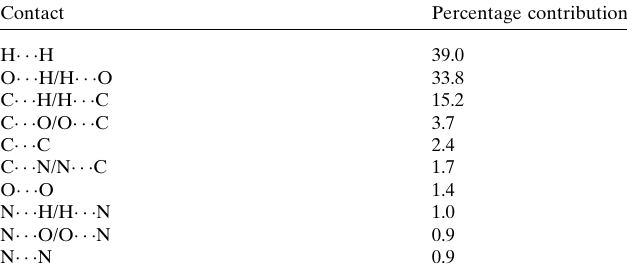
Table 3 Percentage contributions of interatomic contacts to the Hirshfeld surface for (I).